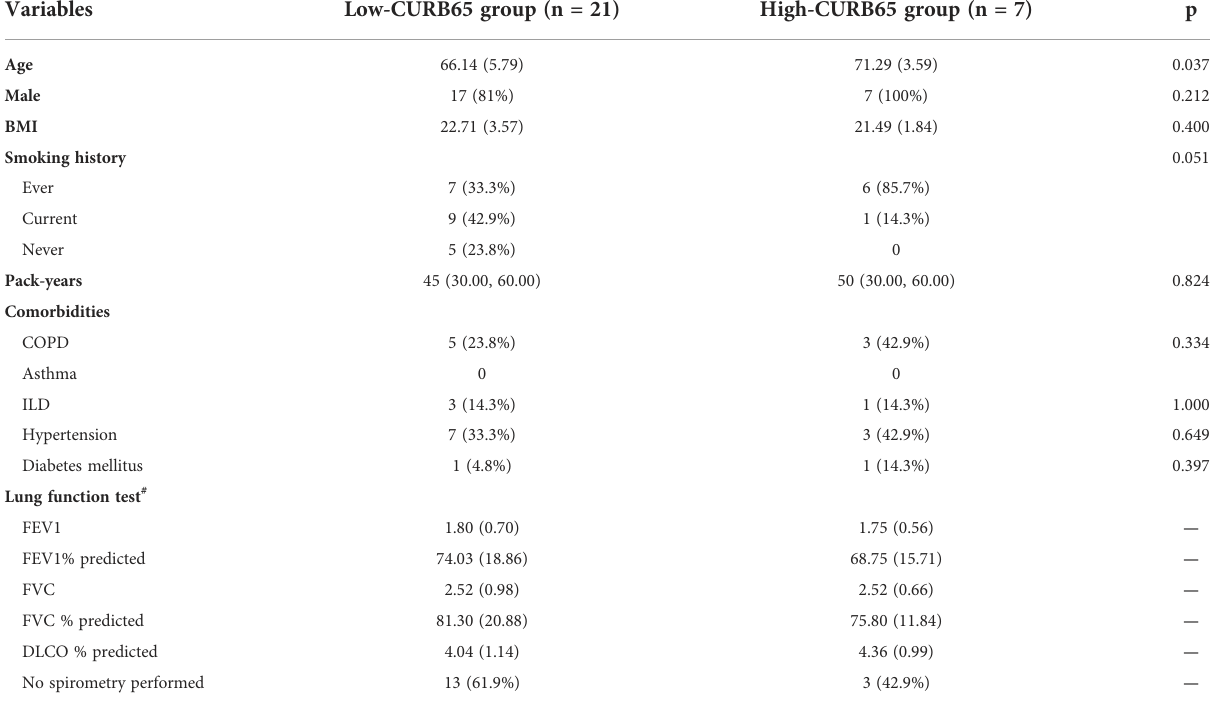
TABLE 1 Baseline demographics, comorbidities, and lung function test